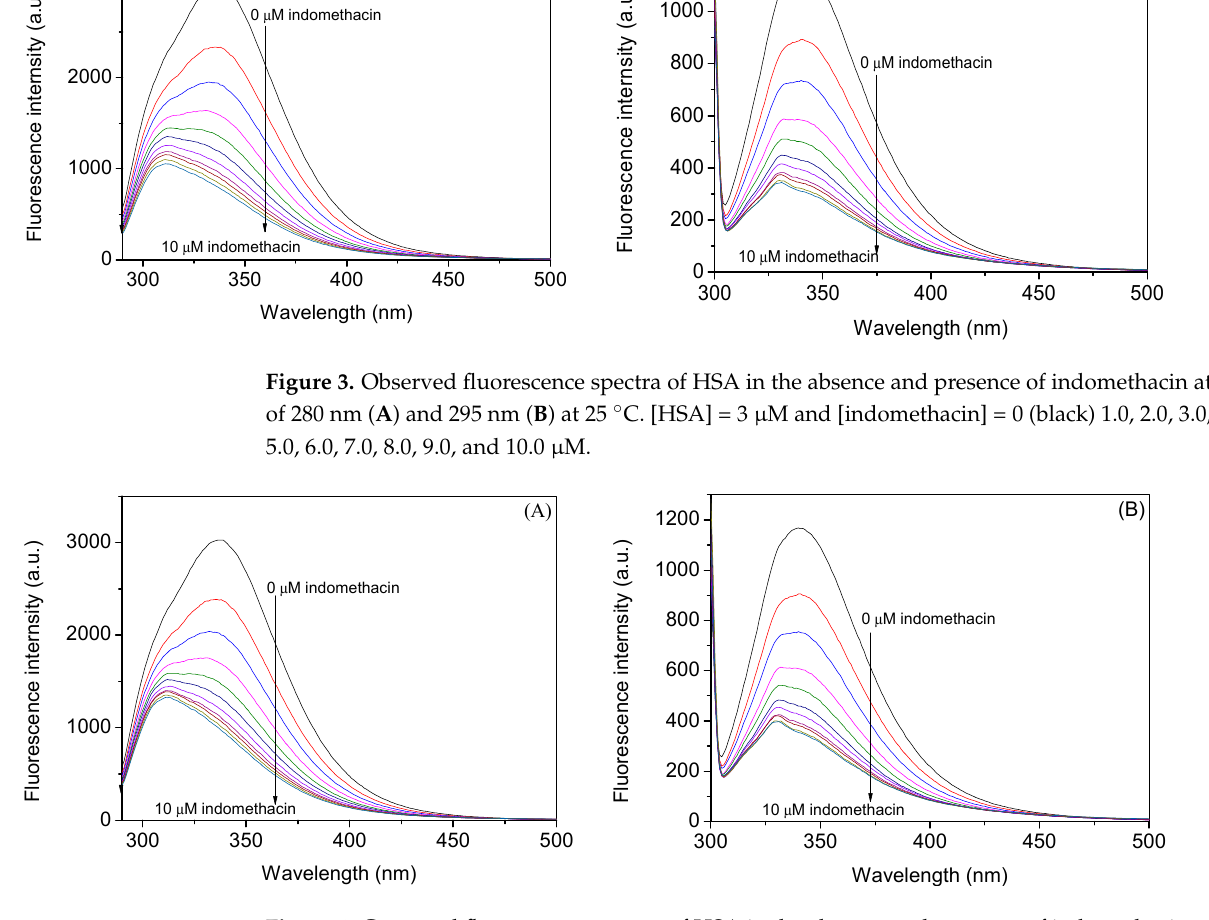
Figure 4. Corrected fluorescence spectra of HSA in the absence and presence of indomethacin at λ ex of 280 nm ( A ) and 295 nm ( B ) at 25 °C. [HSA] = 3 µM and [indomethacin] = 0. 1.0, 2.0, 3.0, 4.0, 5.0, 6.0, 7.0, 8.0, 9.0, and 10.0 µM.